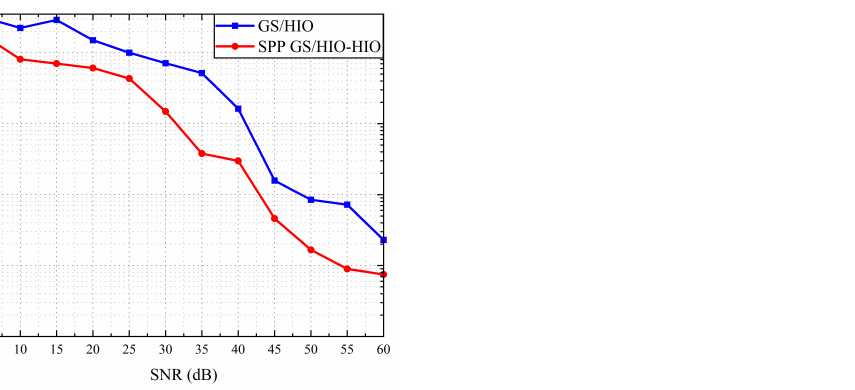
Figure 13. The comparison of the NRMSE of the phase of the entire plane retrieved by the two algorithms under different SNRs.